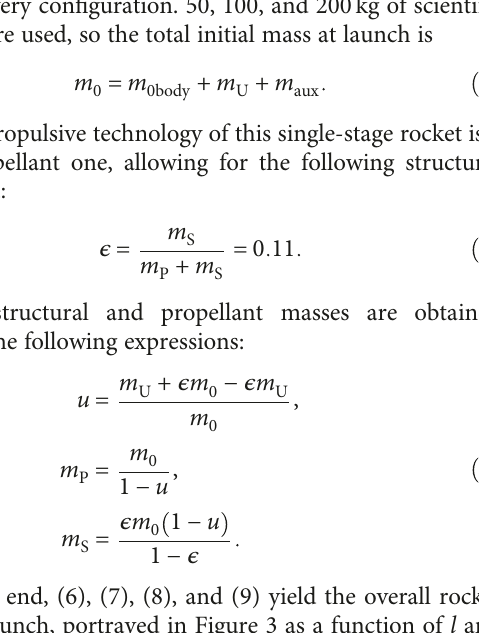
and m with m = 50kg 0 P U